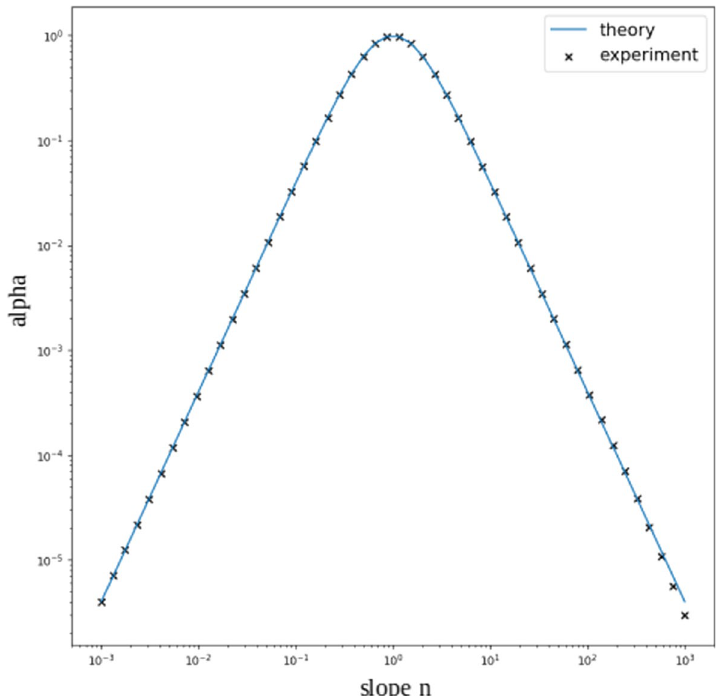
Fig. 6 Illustration of the numerical errors arising from invertible activation layers. Comparison of the theoretical and empirical evolution of the α ratio for different negative slopes n . Empirical values were computed for a Gaussian input signal with zero mean and standard deviation 1 and a white Gaussian noise of standard deviation